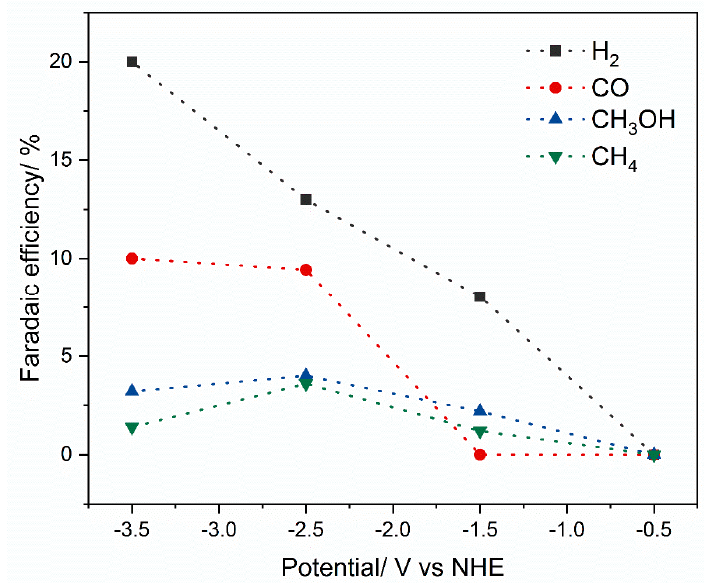
Figure 8. Effect of potential on the product distribution in a solid polymer electrolyte (SPE) reactor.